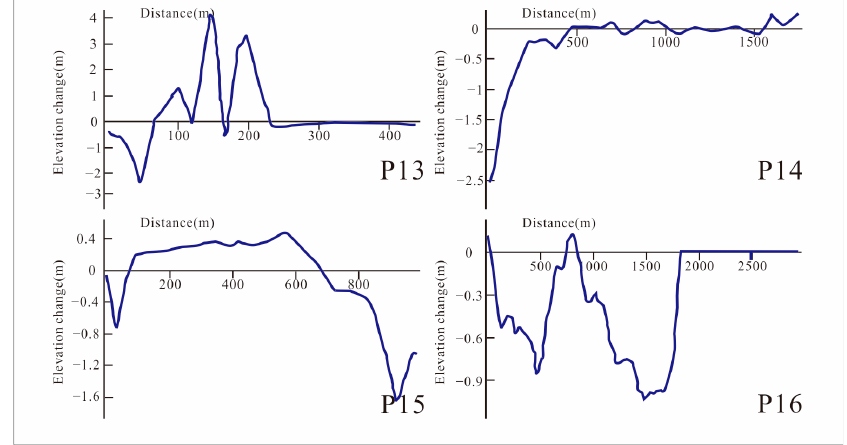
Figure 13. Elevation change in cross-section (P13 to P16).